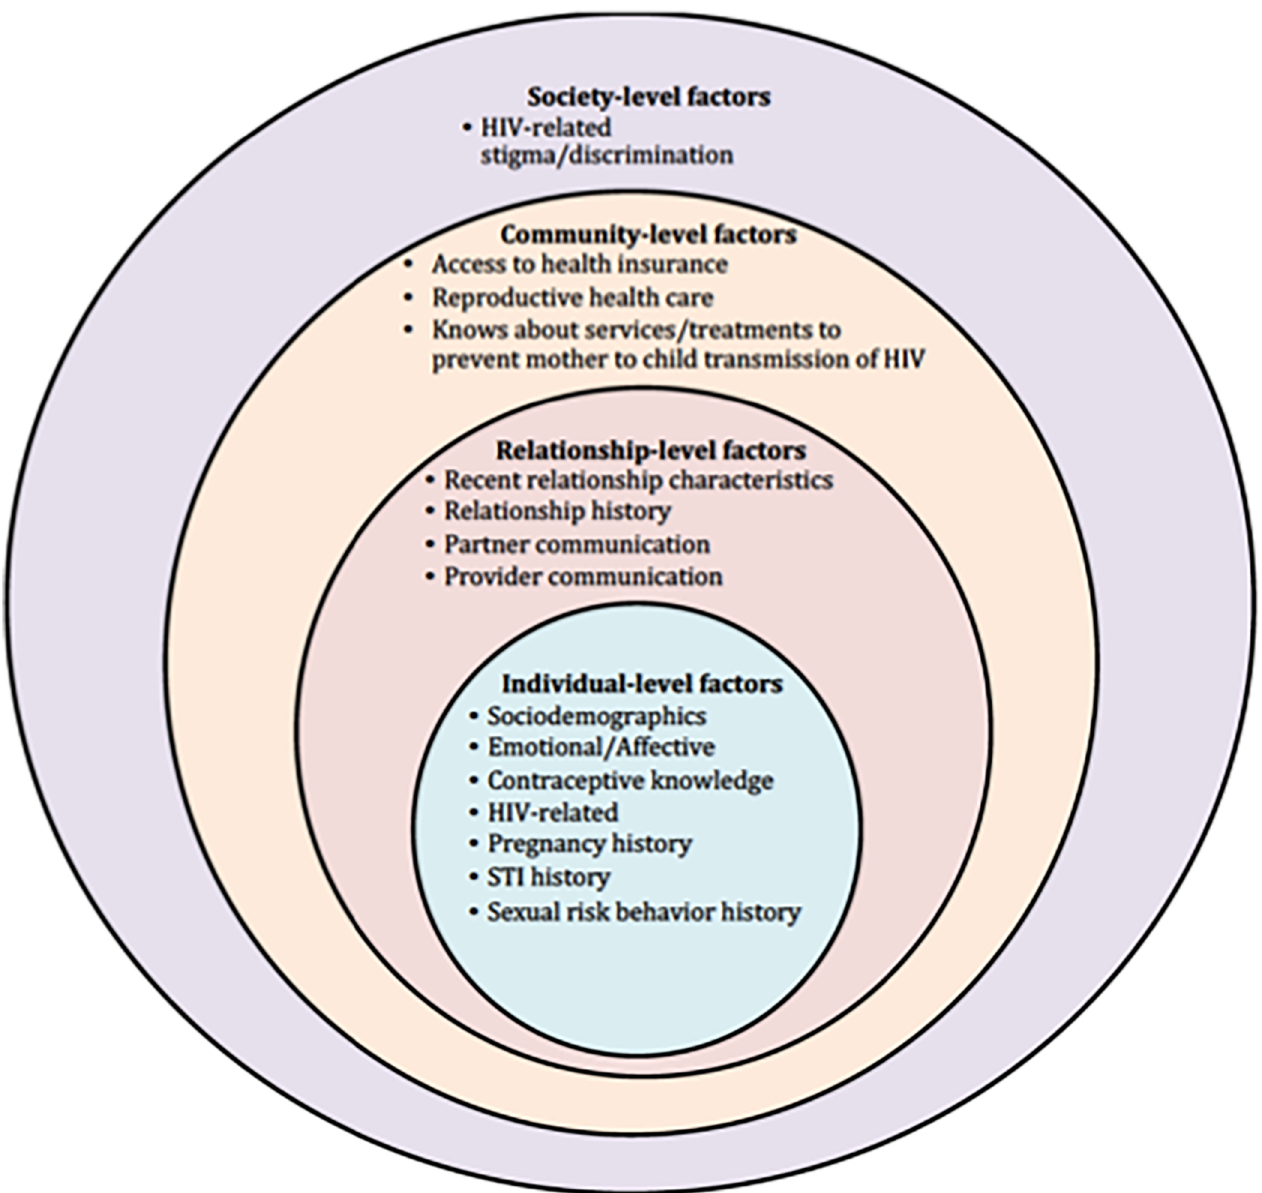
Fig 1. Social-ecological model utilized in this study for evaluating most or moderately effective contraception use, condoms use and dual method use.